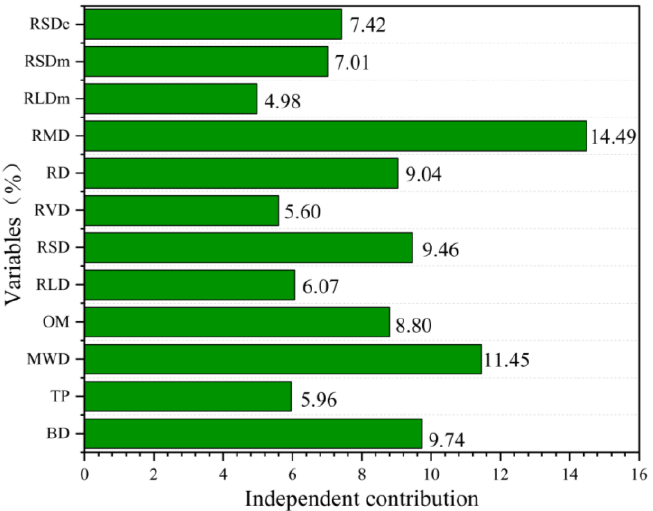
Figure 8. Contribution of root system and soil properties to the effect of soil detachment capacity.